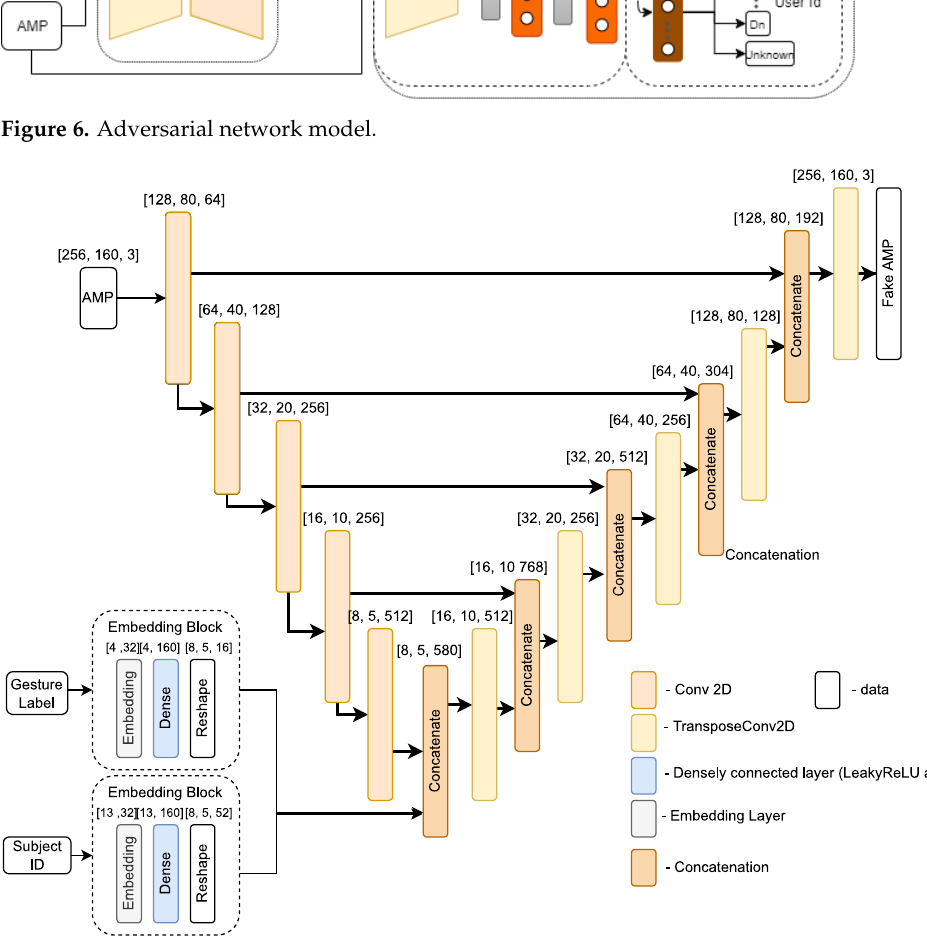
Figure 7. UNet model